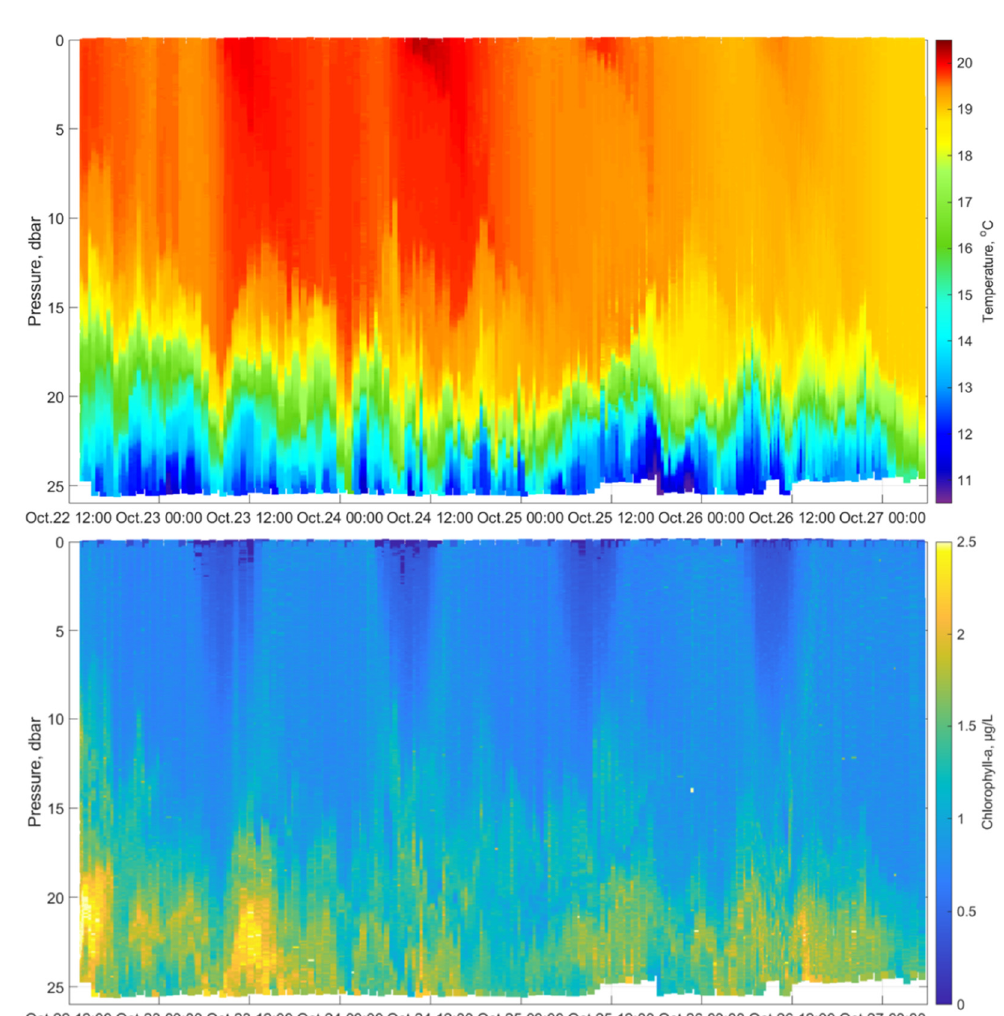
Figure 13. Profiles of the temperature ( upper panel ) and fluorescence-based chlorophyll-a concentrations ( lower panel ) depicted in color for the same period as in Figure 11.